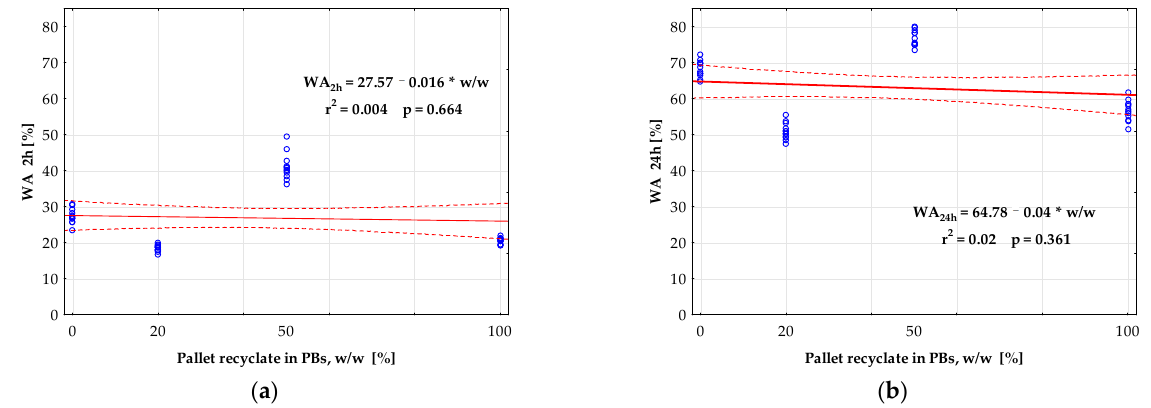
Figure 6. Water absorption (WA) after 2 h ( a ) and 24 h ( b ) of PBs containing different amount of particles from recycled spruce pallets (RSP).